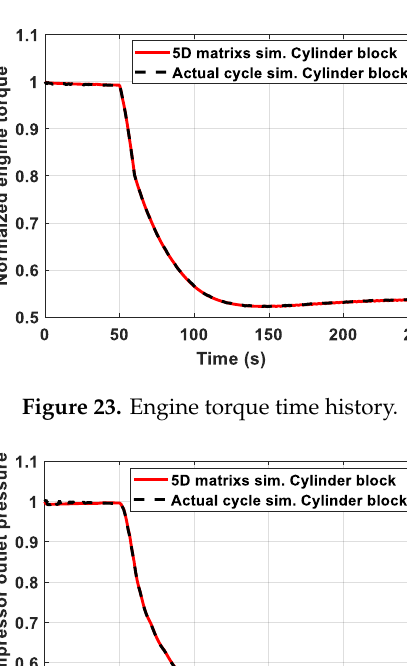
Figure 22. Engine power time history.